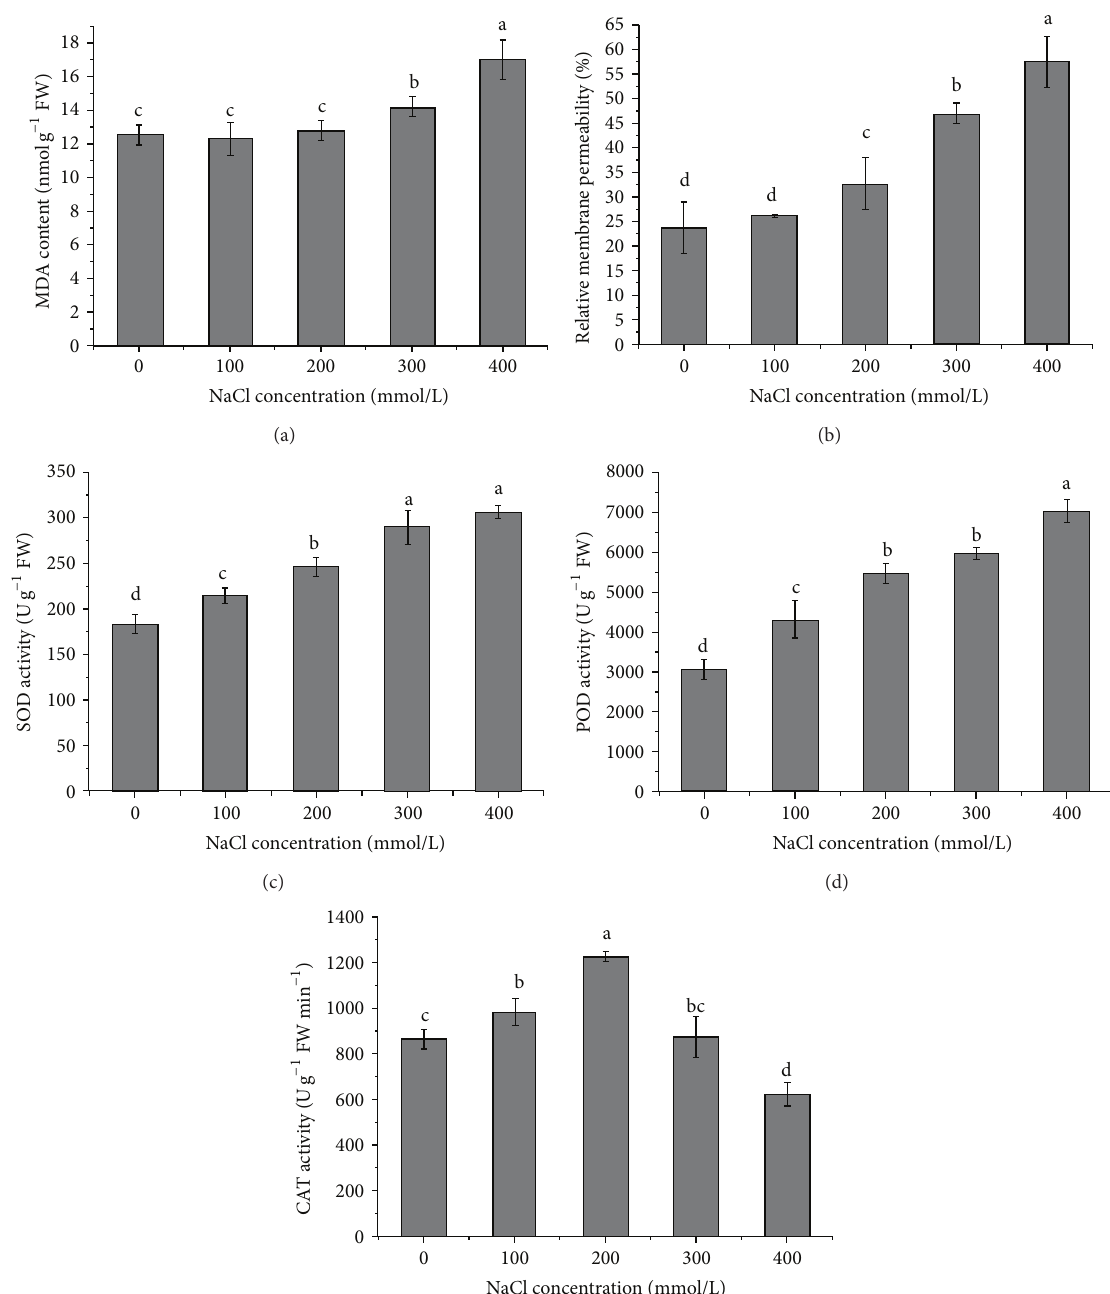
Figure 4: Changes of MDA (a), relative membrane permeability (b), SOD activity (c), POD activity (d), and CAT activity (e) in seedlings exposed to different NaCl